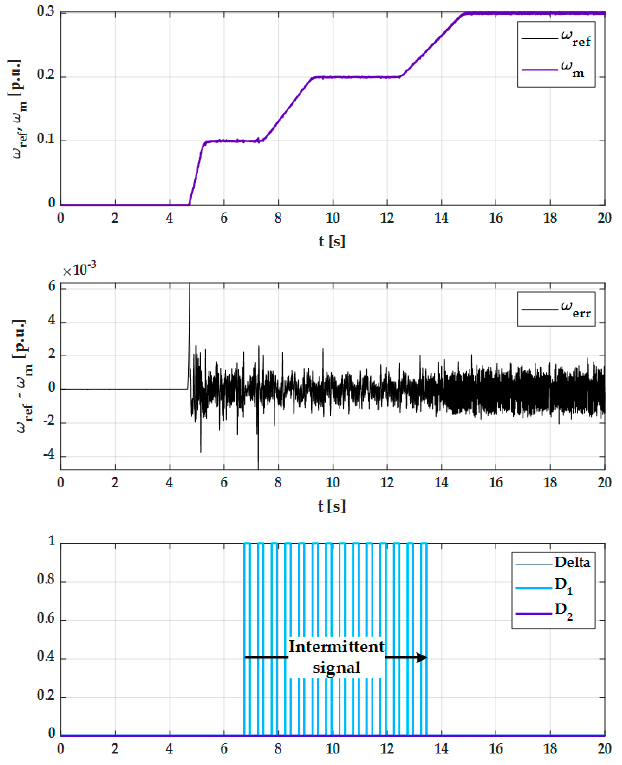
Figure 14. Transients of speed, speed error, and detector response during dynamic interruptions in phase A in a structure with damage compensation.